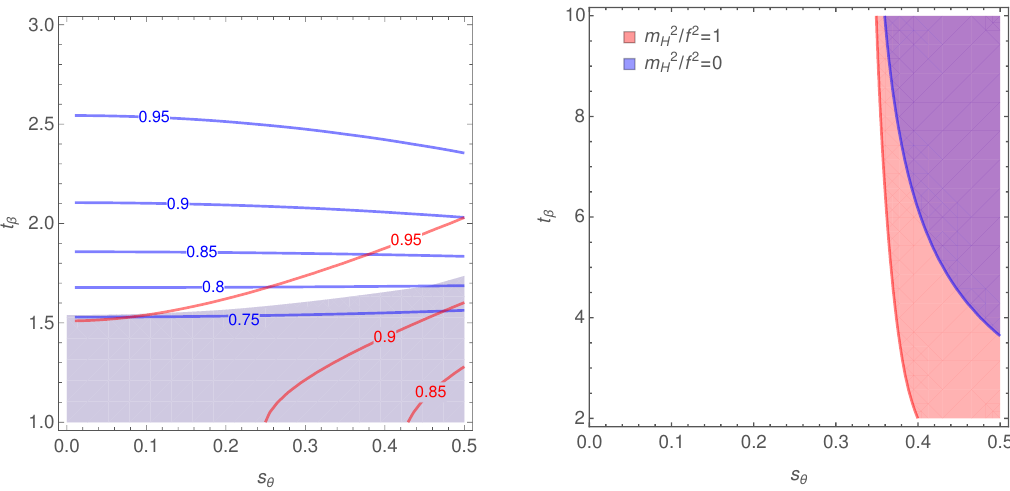
Figure 6 . Left panel: the blue (red) curves show j (cid:20) t j ( j (cid:20) V j ) for m 2 shows the 2 (cid:27) exclusion from the two-parameter (cid:20) f ; (cid:20) V (cid:12)t [28]. Right panel: region in which (cid:20) b is within 2 (cid:27) of the measured value j (cid:20) b j = 0 : 57 (cid:6) 0 : 16, improved w.r.t. the SM prediction.